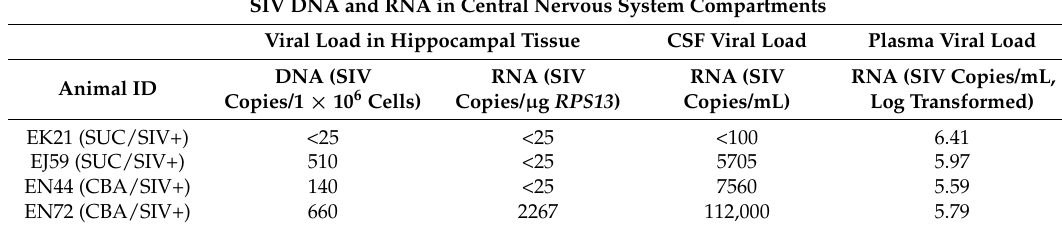
Table 1. Simian immunodeficiency virus (SIV) DNA and RNA copy numbers in hippocampal tissue isolated at necropsy and cerebrospinal fluid (CSF) seven months prior to necropsy. Copy